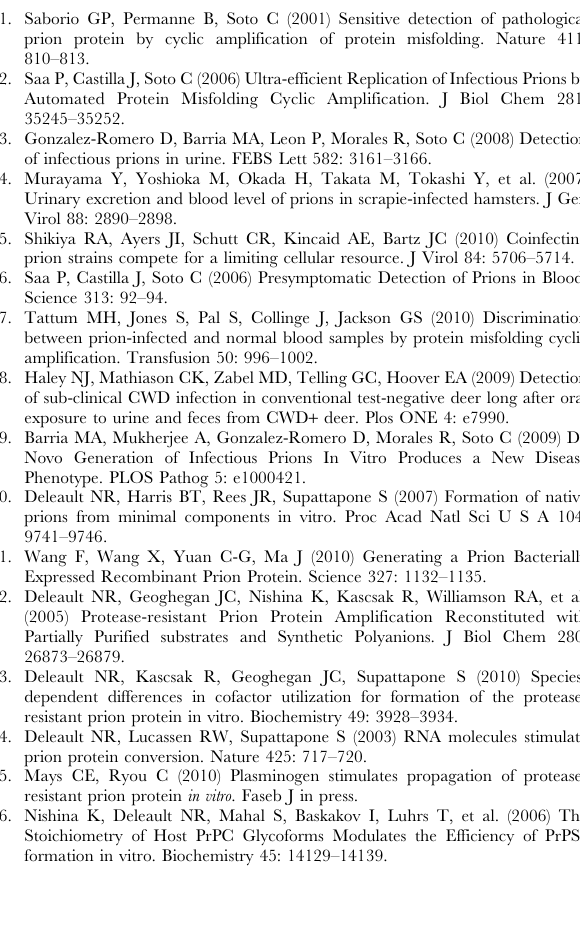
and subjected to a three rounds of PMCA in the absence of beads (top panel) or presence of 3 large beads (bottom panel) and digested with PK. The material amplified in each round was diluted 10-, 20-, 100-, or 1000-fold into 10% NBH for the next PMCA round, as indicated. Each PMCA round consisted of 48 cycles. Undigested 10% NBH (lane 1) is provided as a